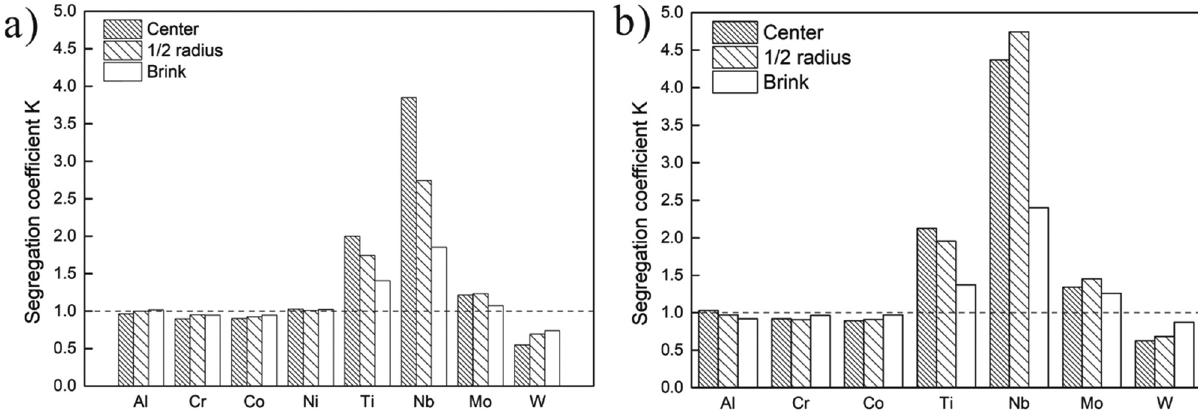
Figure 6: Segregation coe ffi cient K of elements in as - cast René 65: ( a ) sample Disk I and ( b ) sample Disk